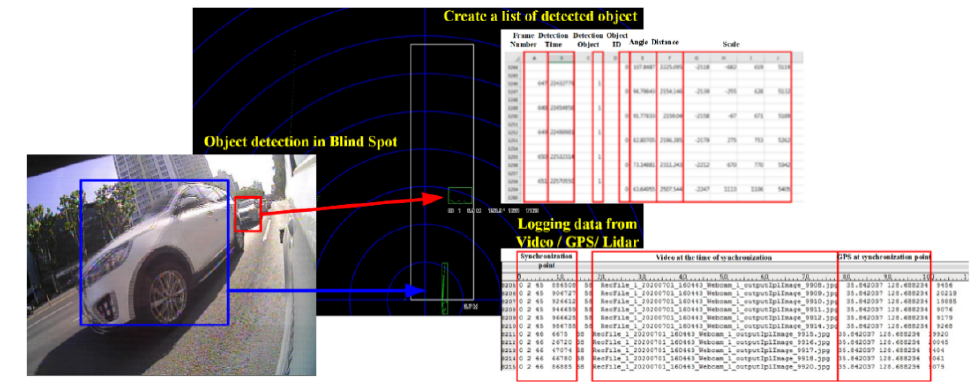
Figure 14. Object detection results using data acquired from GPS, camera, and LIDAR sensors of the proposed system.